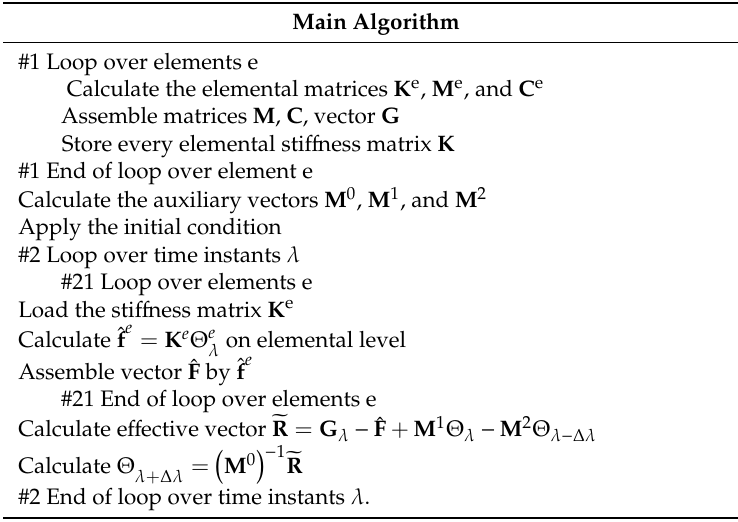
Table 1. The main